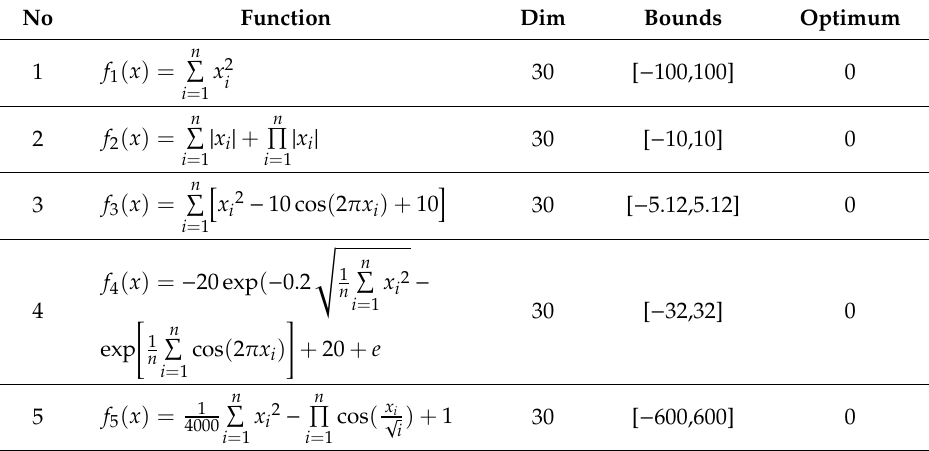
Table 1. Benchmark functions.